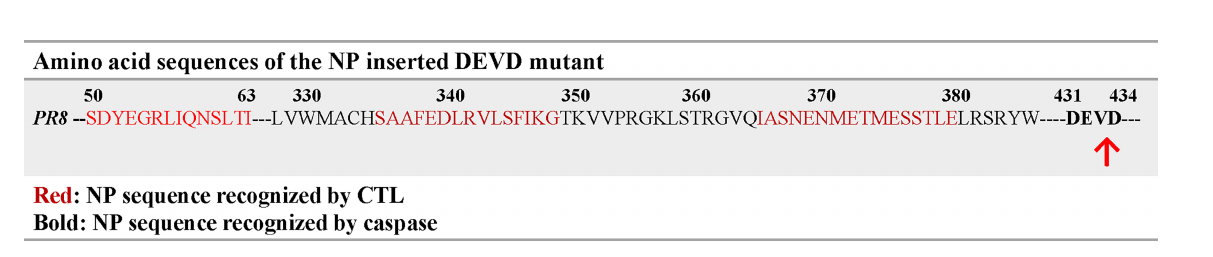
FIGURE 9 | Amino acid sequences of the NP inserted DEVD mutant NP sequences of recognized by CTL were written in red, and NP sequences of recognized by caspase were written in bold. The caspase cleavage site was indicated by red